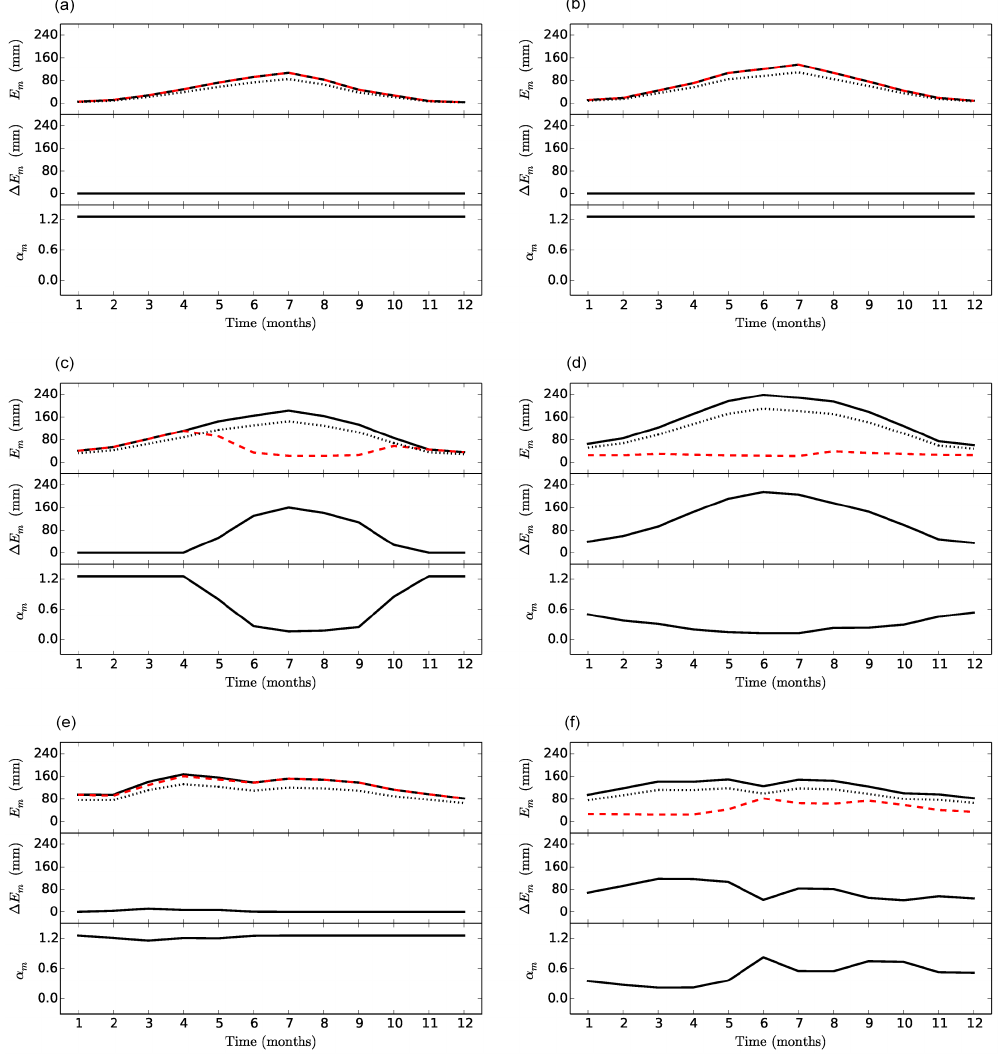
Figure 5. Monthly SPLASH results of evapotranspiration, E m (potential in solid black, actual in dashed red, and equilibrium in dotted black), climatic water deficit, (cid:49)E m , and Priestley–Taylor coefficient, α m , for the six climate regions defined in Fig. 3: (a) tundra, (b) continental with warm summers, (c) temperate with dry summers, (d) hot arid desert, (e) equatorial monsoon, and (f) cold arid steppe. Months of the year are represented along the x axis. Results are of 1 year